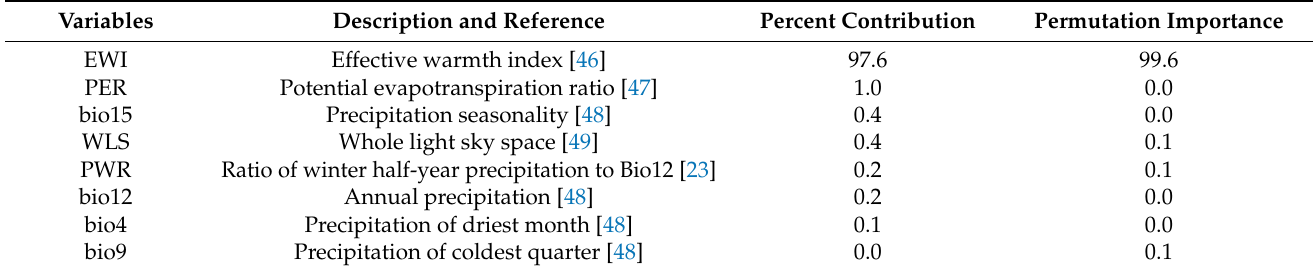
Table 2. Percent contribution and permutation importance of the eight variables used in MaxEnt.